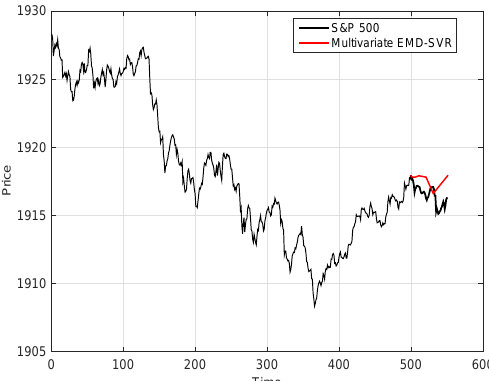
Figure 4. True (black line) and forecasted (red line) values for the S&P 500 index. Forecasted values were obtained using the multivariate empirical mode decomposition–support vector regression (EMD–SVR) model (Equation (9)). The true S&P 500 index values are the same as in Figures 1 and 3. We note that the EMD was performed on the training set only (i.e., using only data before beginning of